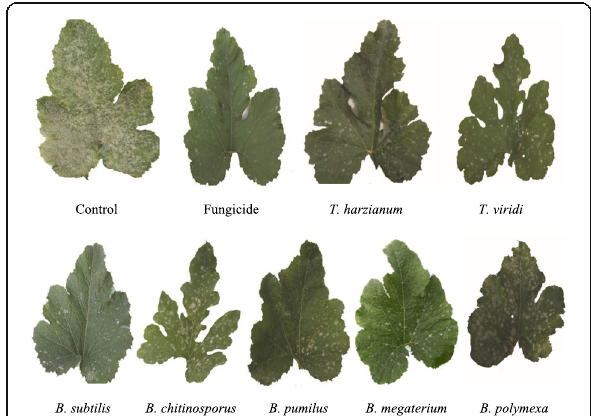
Fig. 1 Effect of different bio-agents ( T. harzianum , T. viridi , B. subtilis , B. chitinosporus , B. pumilus , B. megaterium , and B. polymexa ) compared with fungicide (Topas100) and control treatments on the disease symptoms of squash leaves infected with powdery mildew pathogen ( P. xanthii )